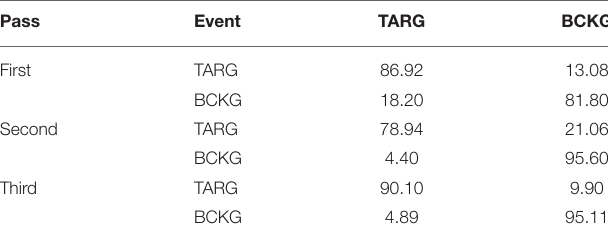
TABLE 5 | The 2-way classification results for the three passes of